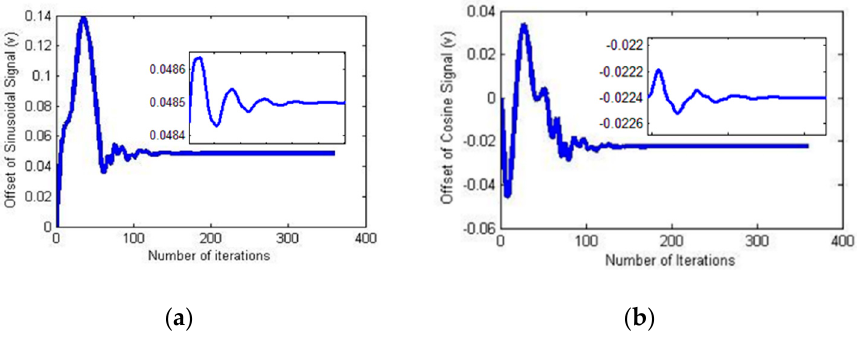
Figure 9. Estimation process. ( a ) DC offset of the sine signal; ( b ) DC offset of the cosine signal.